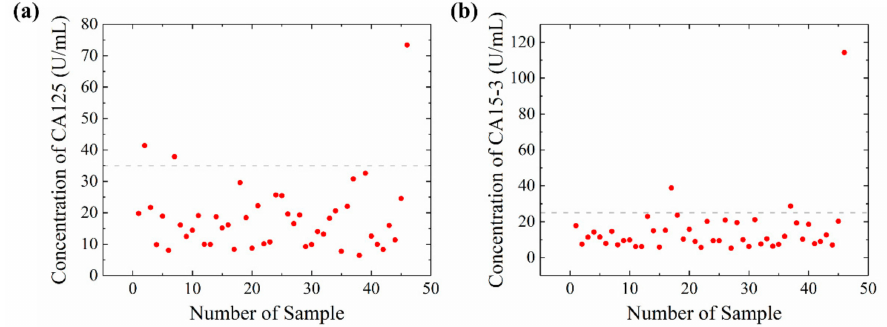
Figure 9. Concentration of CA125 and CA15-3 in serum samples. ( a ) The concentration of CA125. Gray dash line at 35 U / mL, which is the reference concentration of CA125 in clinic; ( b ) The concentration of CA15-3. Gray dash line at 25 U / mL, which is the reference concentration of CA125 in